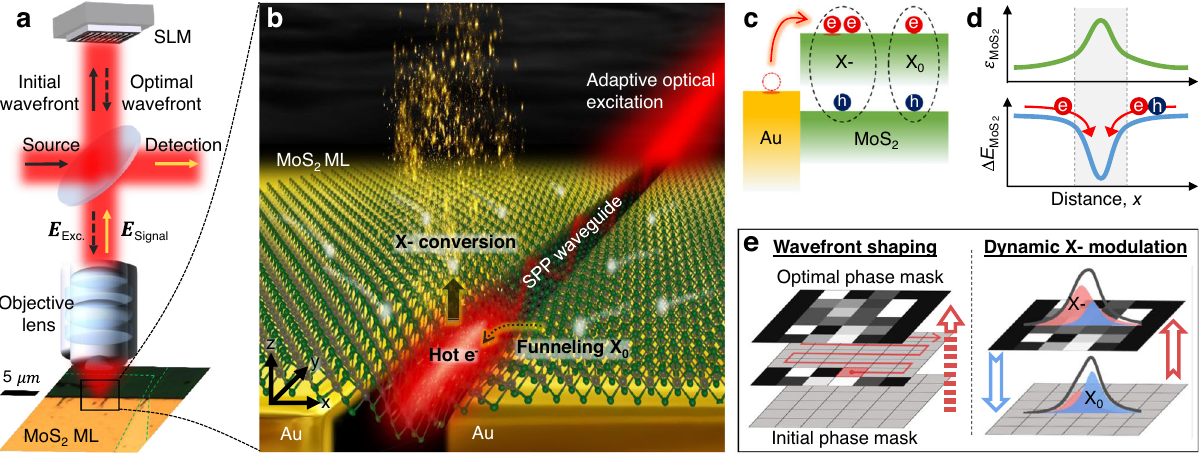
Fig. 1 | Illustration of propagating SPP and exciton-to-trion conversion with dynamic optical modulation. a Schematic diagram of all-optical trion control platform operating with adaptive optical excitation. Green dashed line indicates transferred MoS 2 ML. b Illustration of all-optical trion control platform facilitated by nanoscale strain gradient, plasmon-induced hot electrons, and resultant exciton-to-trionconversion. c IllustrationofhotelectroninjectionprocessfromAu